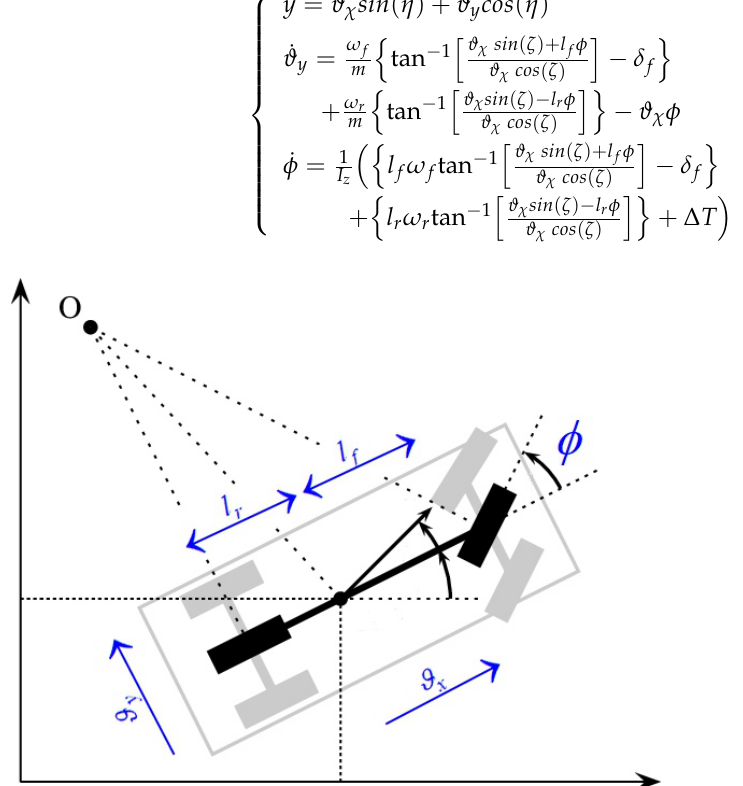
Figure 1. The yaw-plane